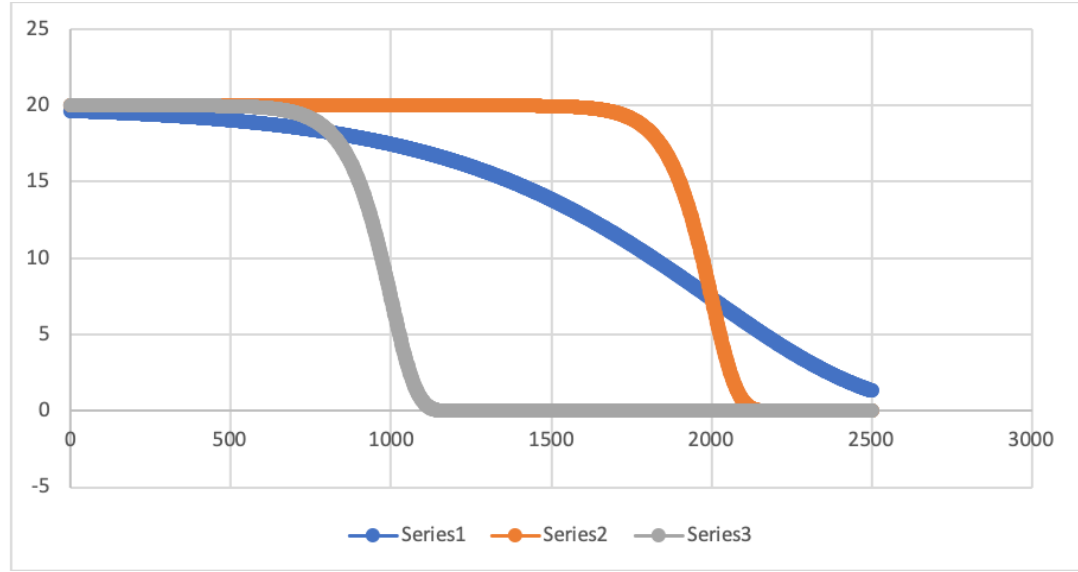
Figure 9. Representation of three different shapes the proposed delay function can have according to the values for p 1 , p 2 and p 3 specified in Table